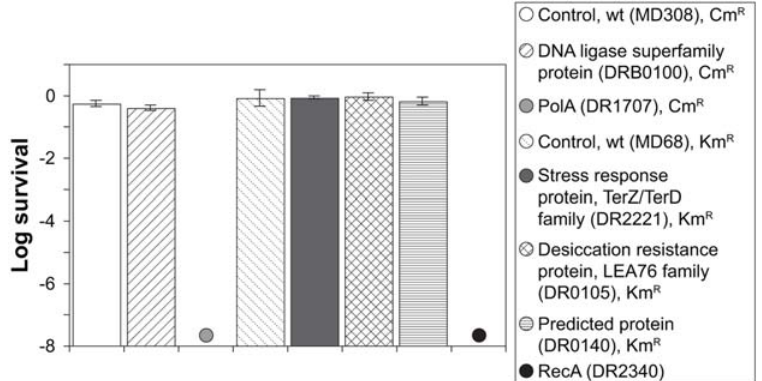
Figure 4. IR resistance of wild-type (ATCC BAA-816) and D.radioduransmutants lacking orthologs in D.geothermalis(DSM 11300). Survival values following 9 kGy ( 60 Co) are from three independent trials with standard deviations shown. The structure of the homozygous mutants DRB0100, DR2221, DR105 and DR0140 are presented in Figure S6.